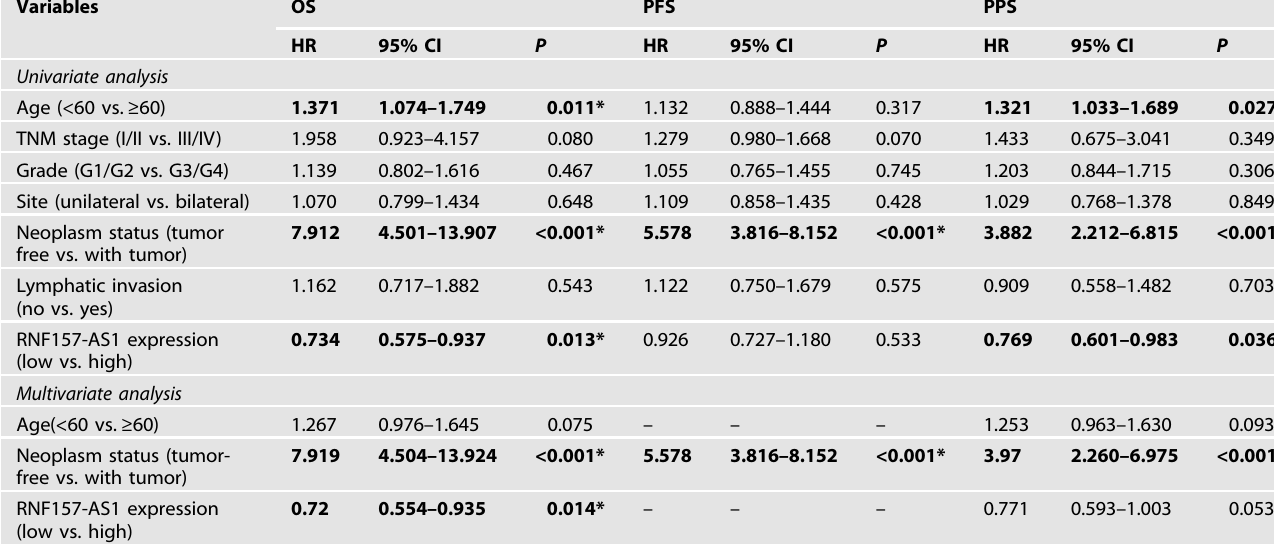
Table 2. Univariate and multivariate Cox regression analysis RNF157-AS1 for OS, PFS, or PPS of EOC patients in TCGA database. Variables OS